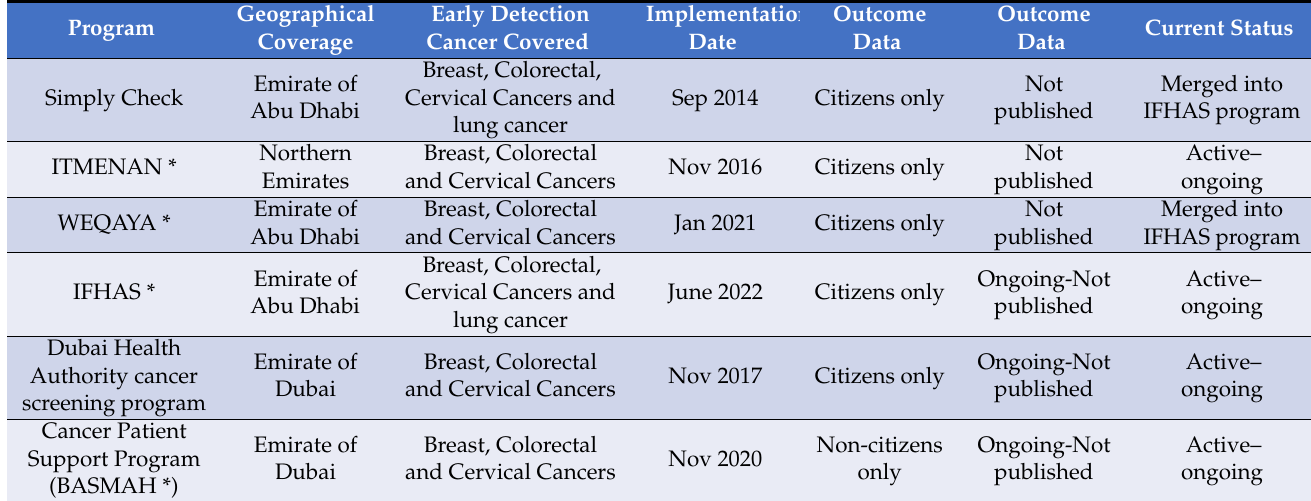
Table 4. Cancer screening programs in the